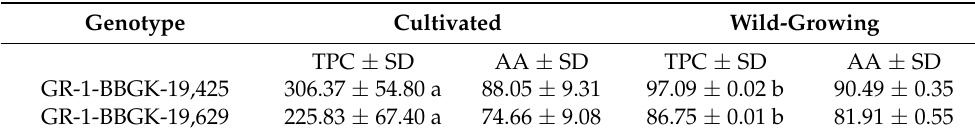
Table 1. Total phenolic content (TPC, mg GAE 100 g − 1 ± SD) and antioxidant activity (AA, % RSA ± SD, n = 3) in fruit samples of wild-growing and cultivated germplasm of two Greek Sambucus nigra genotypes.